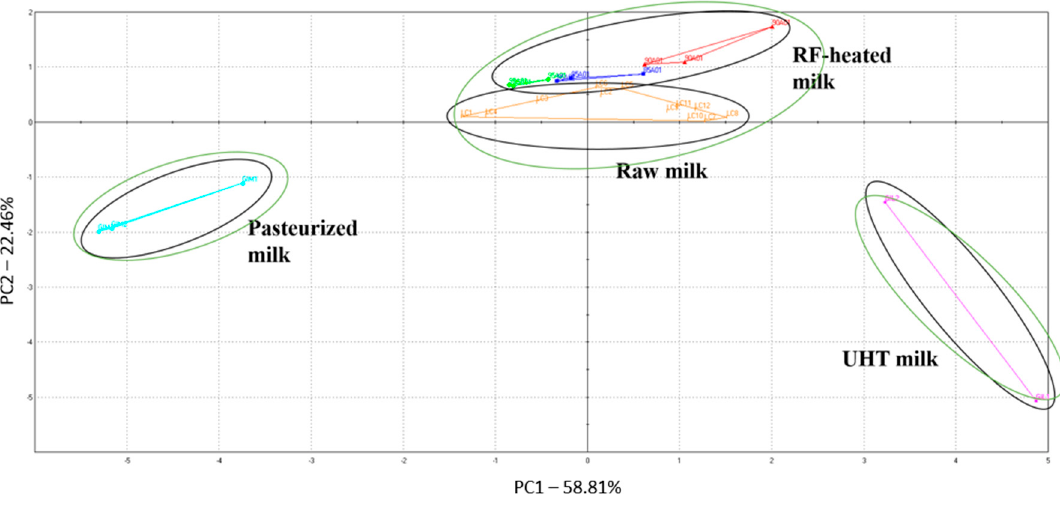
Figure 4. PCA for computer vision. Each different point within the plot refers to different treatment replicates.